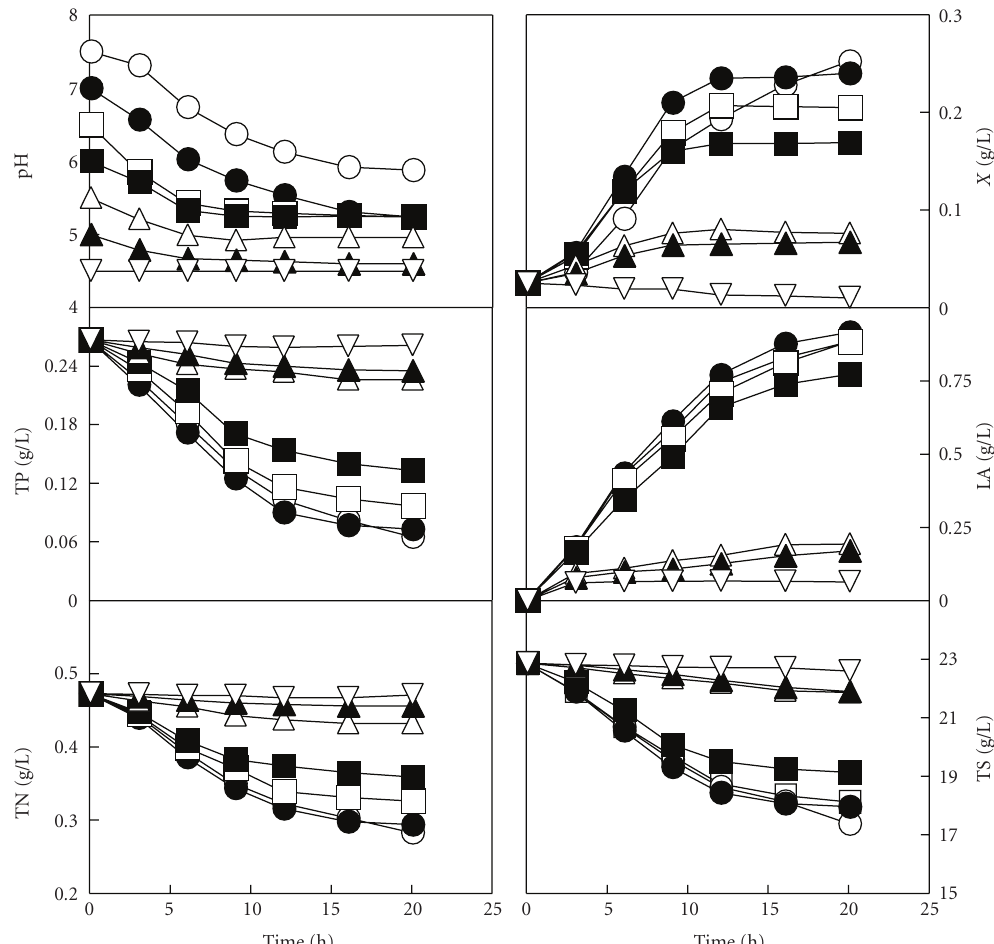
Figure 1: Time course of batch cultures of Ent. faecium CECT 410 on DW medium adjusted to initial pH values of pH 7.5 ( (cid:3) ), pH 7.0 ( • ), pH 6.5 ( (cid:2) ), pH 6.0 ( (cid:3) ), pH 5.5 ( Δ ), pH 5.0 ( (cid:4) ), and 4.5 ( ∇ ). X, biomass; LA, lactic acid; TP, total phosphorous; TN, total nitrogen; TS, total sugars. Data reported are means ± standard deviations of three